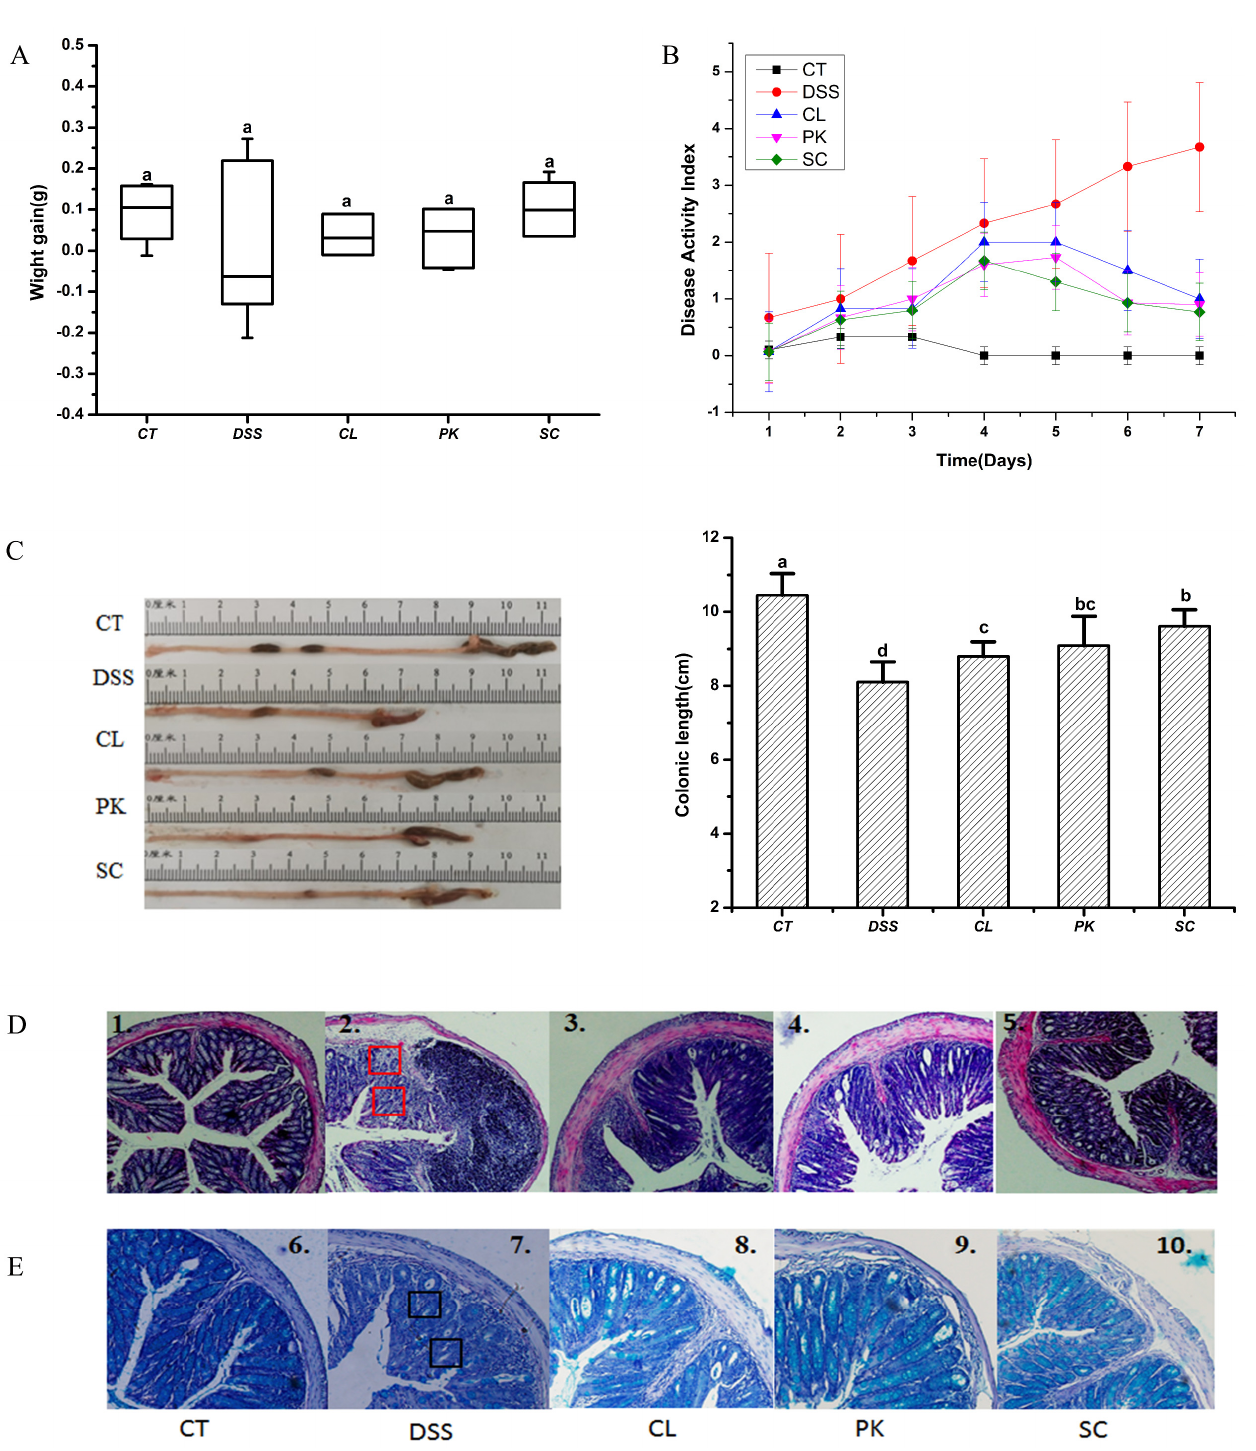
Figure 2. Effects of three yeast strains on symptoms of Balb/c mice with colitis. ( A ) Body weight and ( B ) Disease activity index (DAI) of mice, ( C ) colon morphology and colon length of mice in each group. ( D ) H&E staining (figures 1–5 shows the observation of colonic histological injury of mice in each group). ( E ) Alcian blue staining (figures 6–10 shows the observation of mucin number in colonic tissue of mice in each group). Red marks indicate destruction of crypt structures and inflammatory cell infiltration. Black marks indicate decreased goblet cells and mucins. Different lowercase letters marked on the column represent significant difference ( p <